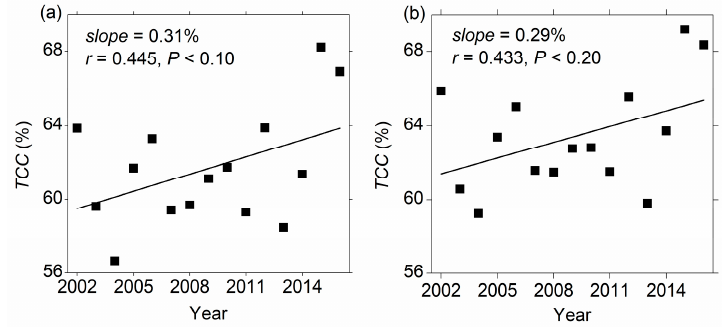
Figure 7. Variations in total cloud cover ( TCC ) from 2002 to 2016 at ( a ) rural and ( b ) suburban sta-